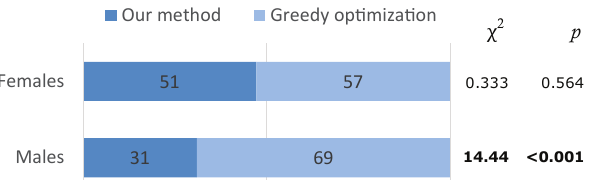
Figure 9. Frequencies of user preferences categorized by